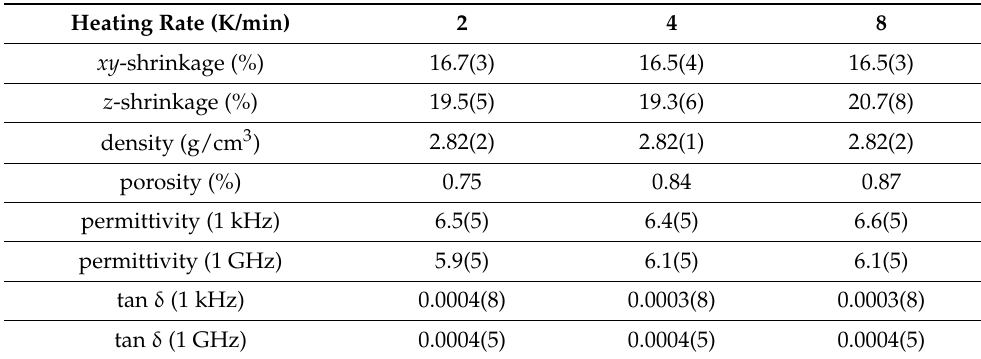
Figure 2. Dilatometer shrinkage and shrinkage rate curves of CT708 green tapes with heating rates of 2 K/min ( a ), 4 K/min ( b ), and 8 K/min ( c ). Table 1. Shrinkage, density, porosity, permittivity, and loss factor (@1GHz) of CT708 samples, sintered at 900 ◦ C, heated with heating